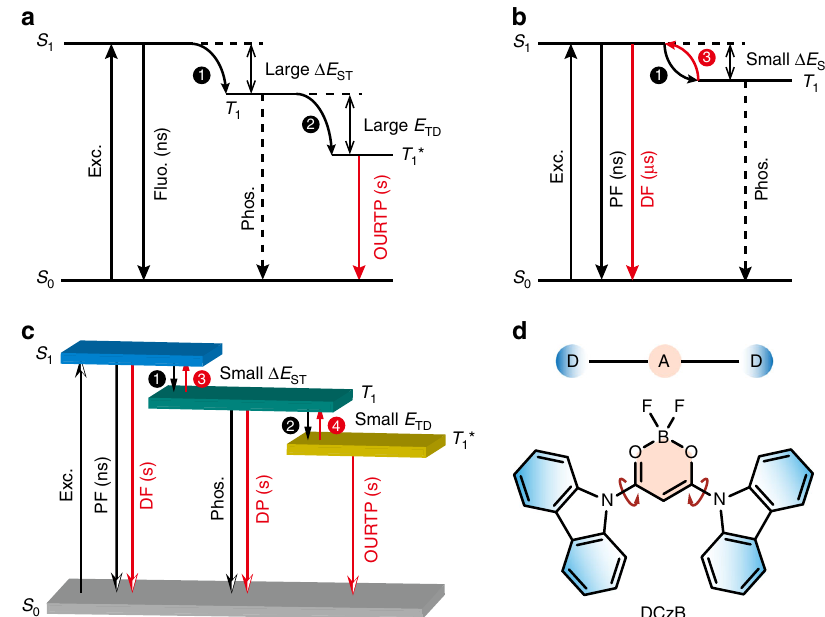
Fig. 1 A mechanism for improving the organic afterglow ef fi ciency. a Mechanism of OURTP by constructing T 1 * in organic aggregates. The molecule in the ground state (S 0 ) is excited (Exc.) to the lowest singlet excited state (S 1 ) for fl uorescence (Fluo.) with lifetime of several nanoseconds (ns) and ISC (step 1) to populate the lowest triplet excited state (T 1 ) for weak phosphorescence (Phos.); when T 1 is stabilized in T 1 * (step 2), the radiative deactivation of T 1 * results in OURTP with lifetime up to seconds (s). b TADF mechanism with facile RISC process (step 3) for delayed fl uorescence (DF) with lifetime around several microseconds ( μ s). c TAA emission realized by thermally activated exciton release (TAER) (step 4) and RISC (step 3) processes. Firstly, the trapped excitons in T 1 * were released by thermal perturbation to T 1 at a small E TD for delayed phosphorescence (DP). Secondly, the released T 1 exciton was transformed to S 1 exciton for the spin-allowed DF at a small Δ E ST . d Design of TAA molecules based on di fl uoroboron β -diketonate and carbazole in a twisted D – A – D